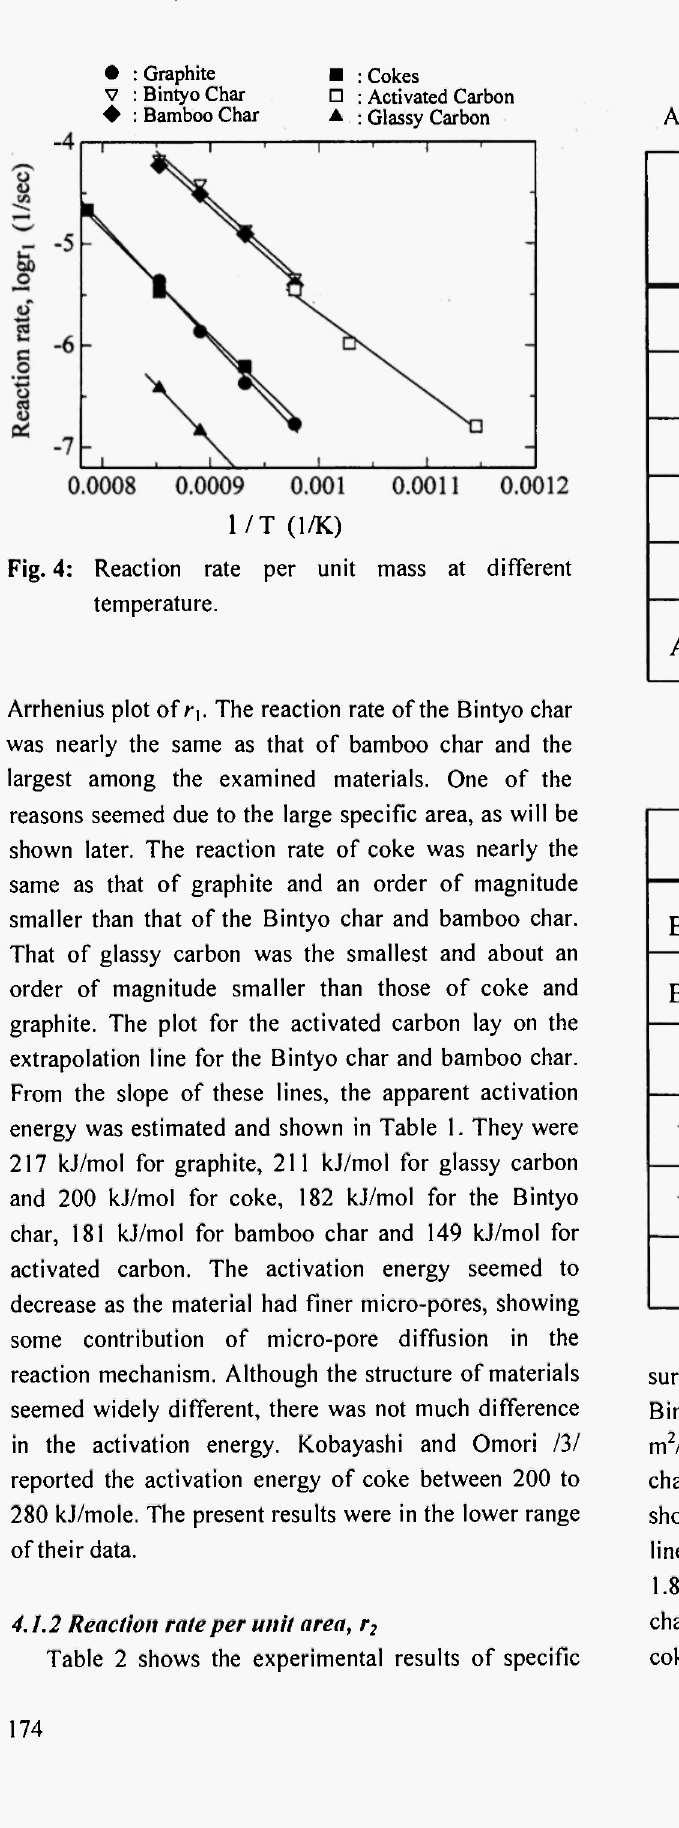
Fig. 4: Reaction rate per unit mass at different temperature.